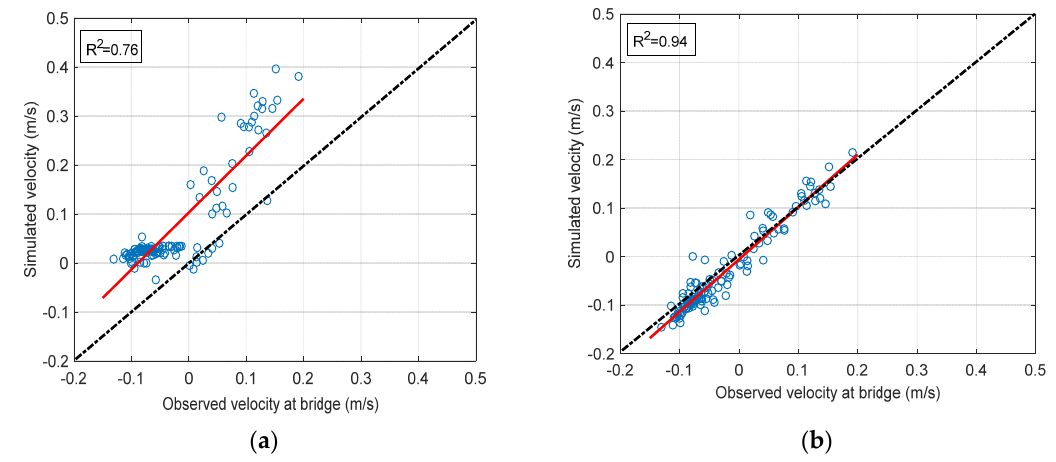
Figure 7. Relationship between simulated and observed velocities: ( a ) before 1 m bathymetry offset and ( b ) after 1 m bathymetry offset.